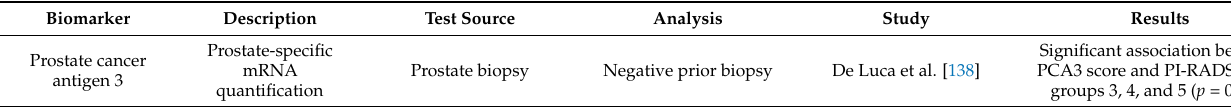
Table 3. Compilations of studies on the association of imaging and